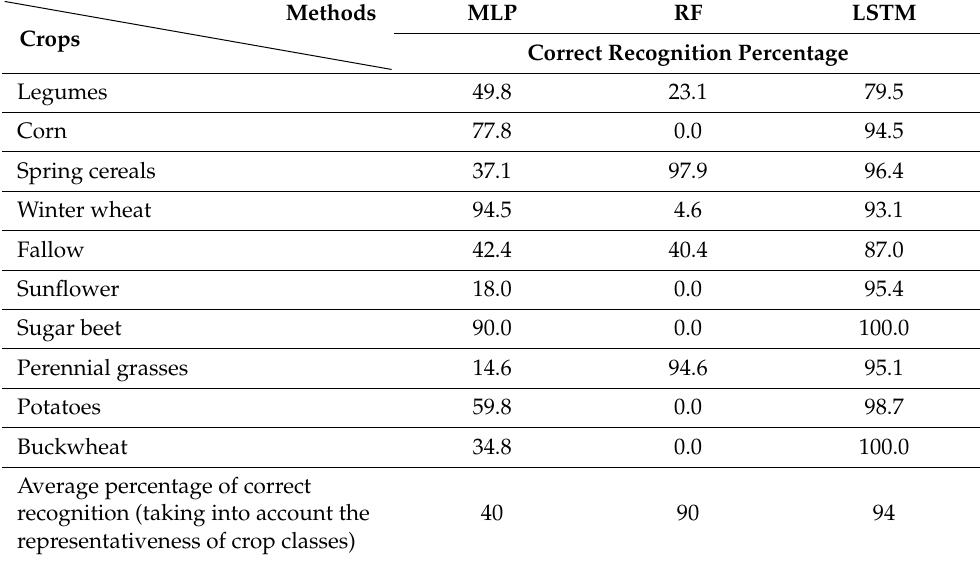
Table 1. Accuracy of recognition of crops classes by time-series NDVI, EVI MODIS in peer territories using three methods of automated classification based on the cross-validation